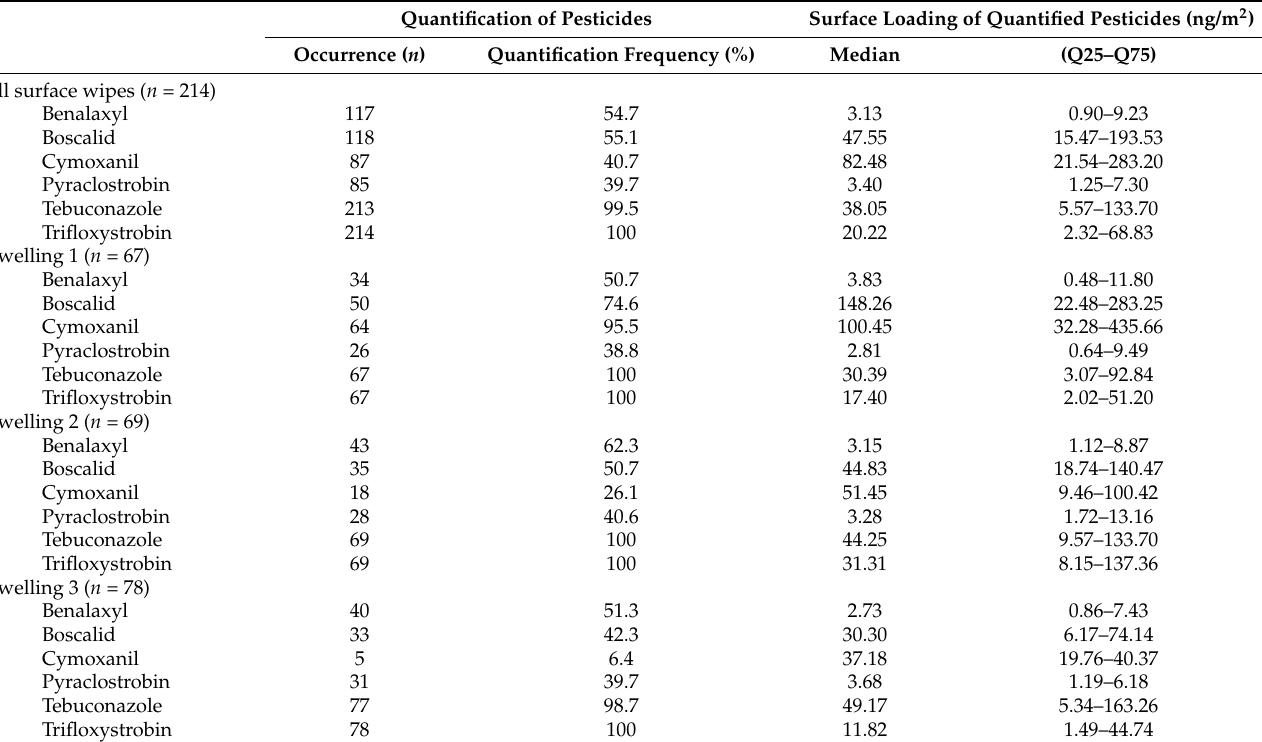
Table 3. Pesticides on surfaces in the three dwellings: quantification frequency and distribution of the surface